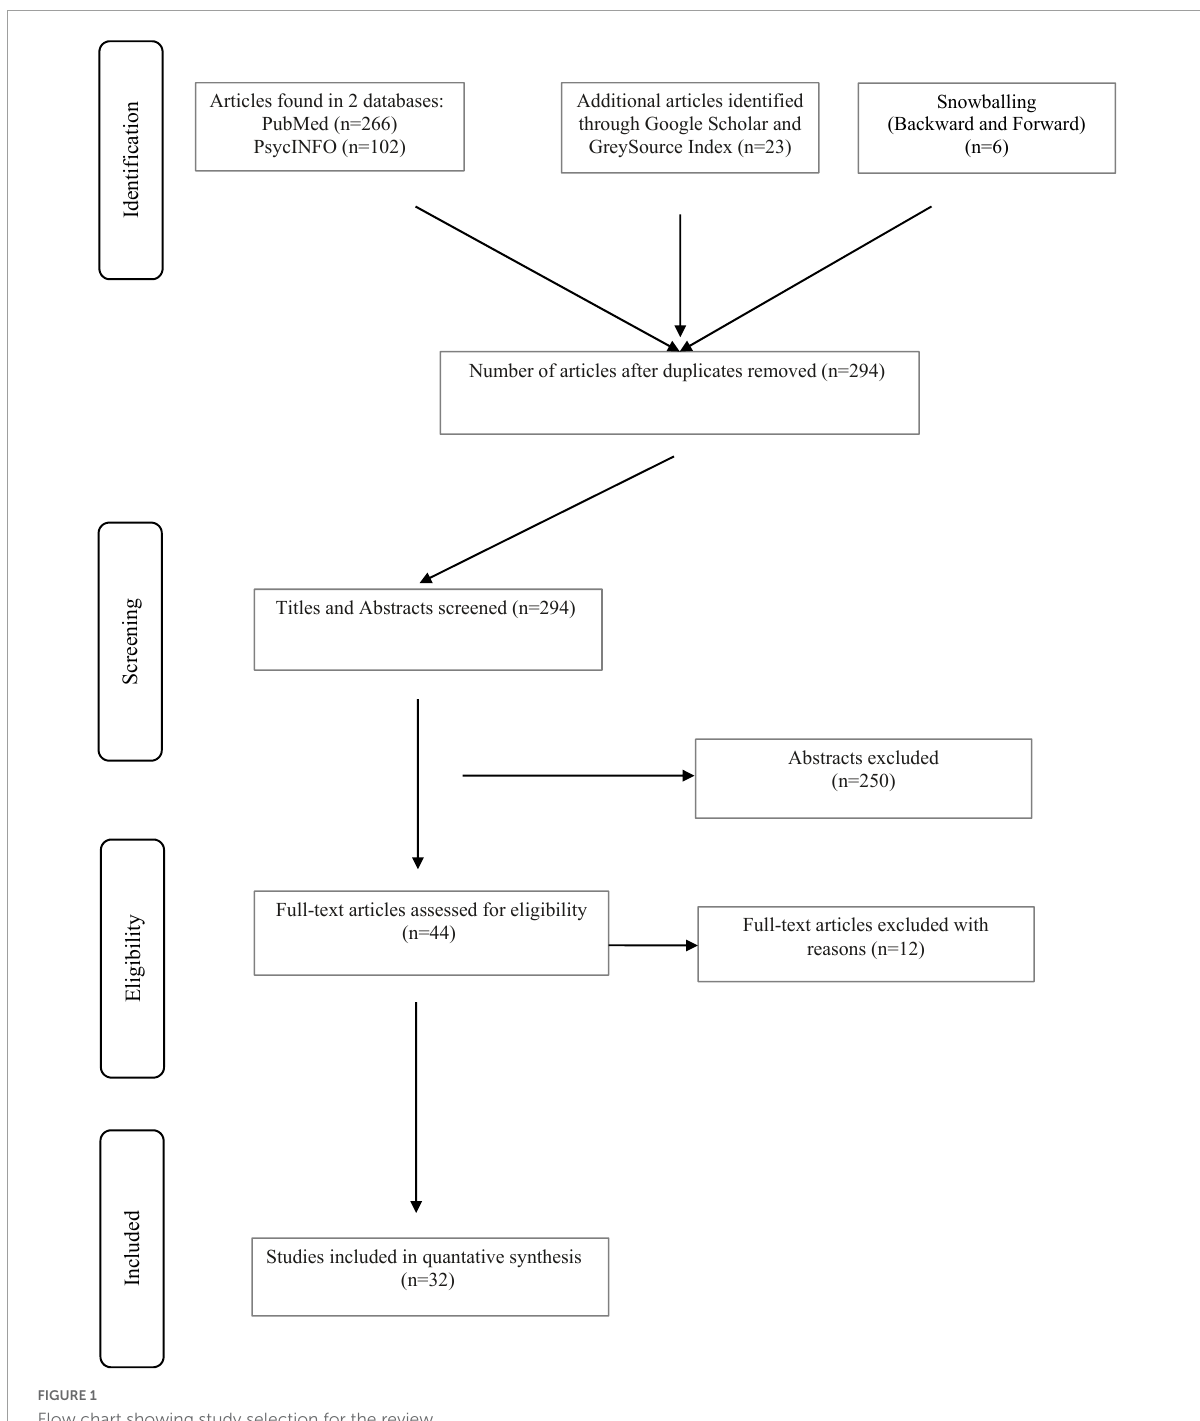
FIGURE1 Flow chart showing study selection for the review.